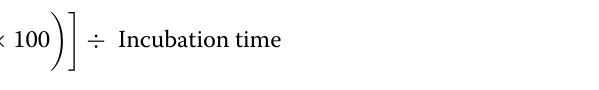
Measurements are averages for the study reaches and were collected in the summer of